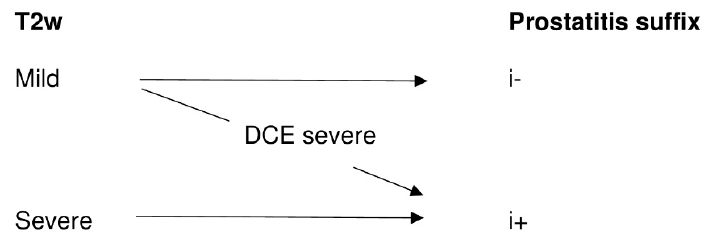
Figure 5. The algorithm used for our proposed inflammation suffix. Mild T2W changes (as described